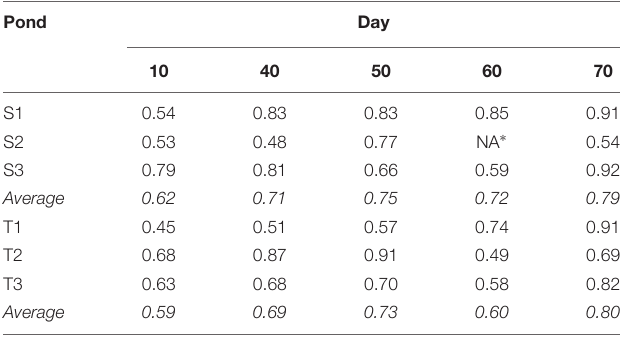
TABLE 3 | Bray–Curtis dissimilarities of bacterial community composition between free-living (FL) and particle-attached (PA) fractions. Pond Day